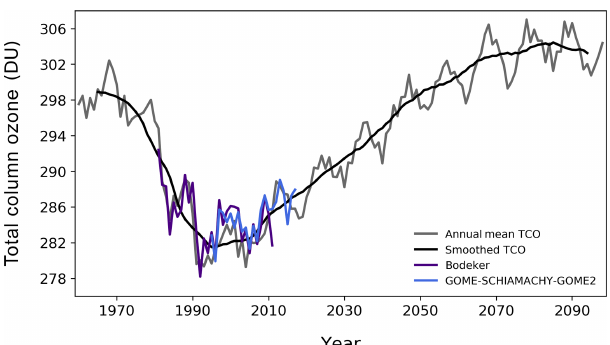
Figure 4. Modelled annual mean TCO values (in DU), averaged from 60 ◦ S to 60 ◦ N, for the BASE (grey line) and smoothed data (black line), using an 11-point boxcar smoothing to reduce the ef- fects of both interannual variability and the solar cycle (follow- ing Dhomse et al., 2018). Also shown are TCO values, averaged over 60 ◦ S–60 ◦ N, from v2.8 of the Bodeker dataset (purple line; Bodeker et al., 2005) and v3 of the GOME/SCIAMACHY/GOME2 Merged Total Ozone dataset (blue line; Weber et al.,